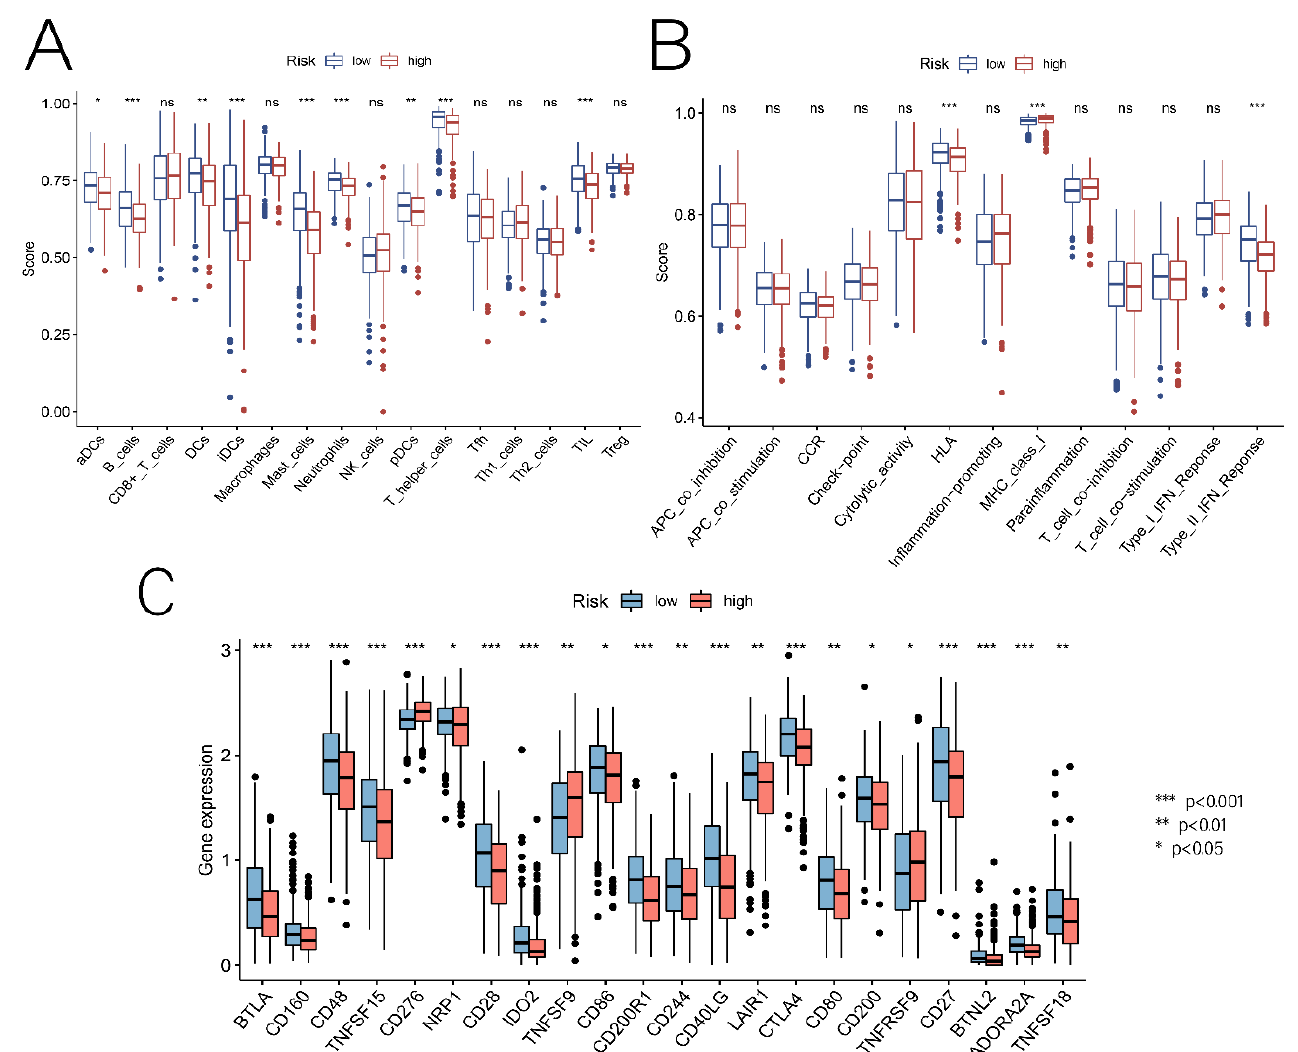
Figure 9. ( A ) Relationship between risk score and immune cell enrichment. ( B ) Relationship be- tween risk score and immune cell-related function. ( C ) Relationship between risk scores and im- checkpoints. * p < 0.05, ** p < 0.01, and *** p < mune checkpoints. * p < 0.05, ** p < 0.01, and *** p < 0.001.